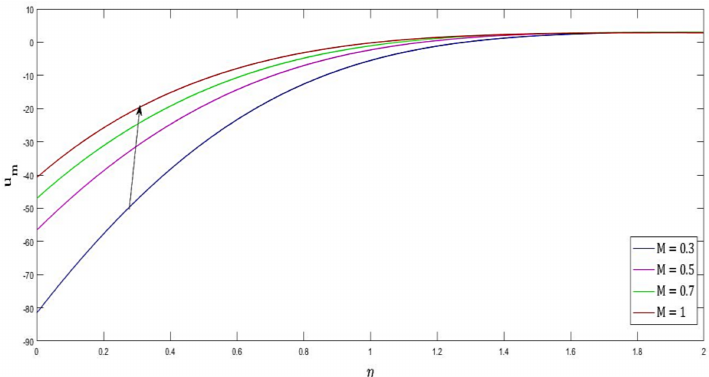
Figure 3. Variation in velocity profile with respect to Hartmann number.